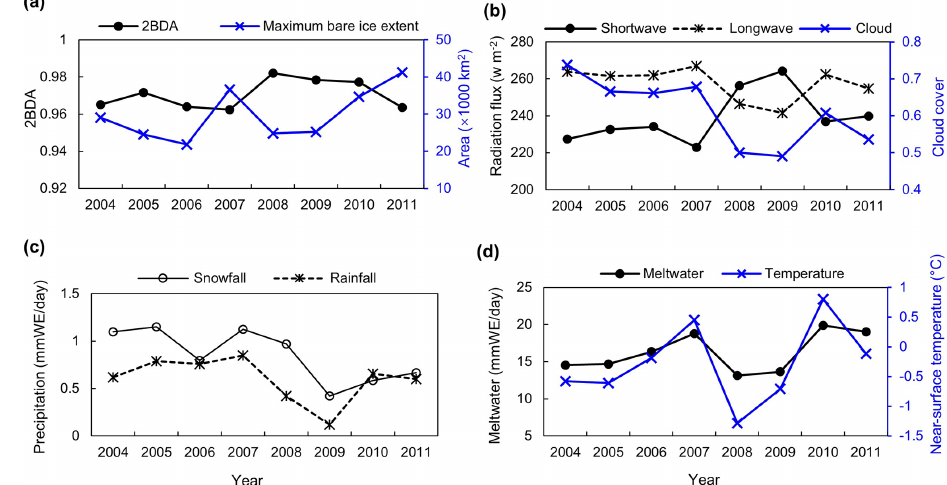
Figure 13. (a) Average 2BDA index over bare ice and maximum bare ice area from 2004 to 2011 (MERIS). (b) July–August mean of downward shortwave and longwave radiation fluxes and cloud cover over the study area from 2004 to 2011 (MAR). (c) July–August mean of rainfall and snowfall (MAR). (d) July–August mean of meltwater production and near-surface temperature (MAR).